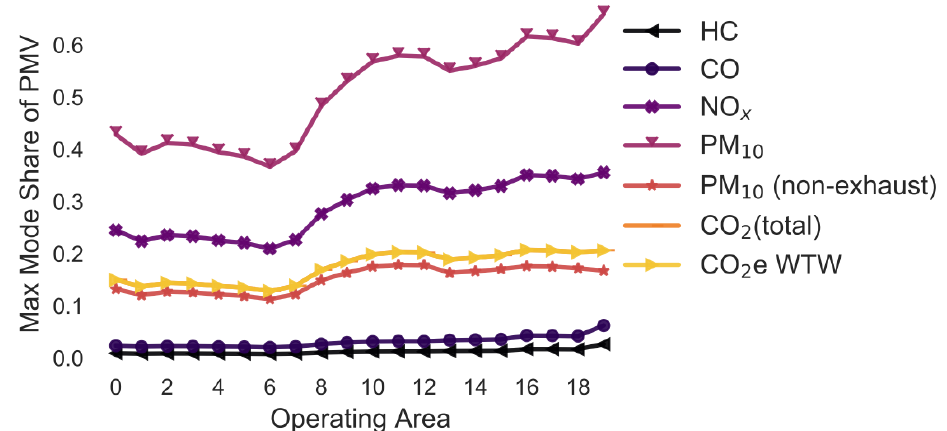
Figure 15. Maximum share of customers who can pick up a parcel by car (varying customer trip length) (note: CO 2 (total) and CO 2 e WTW are the same).